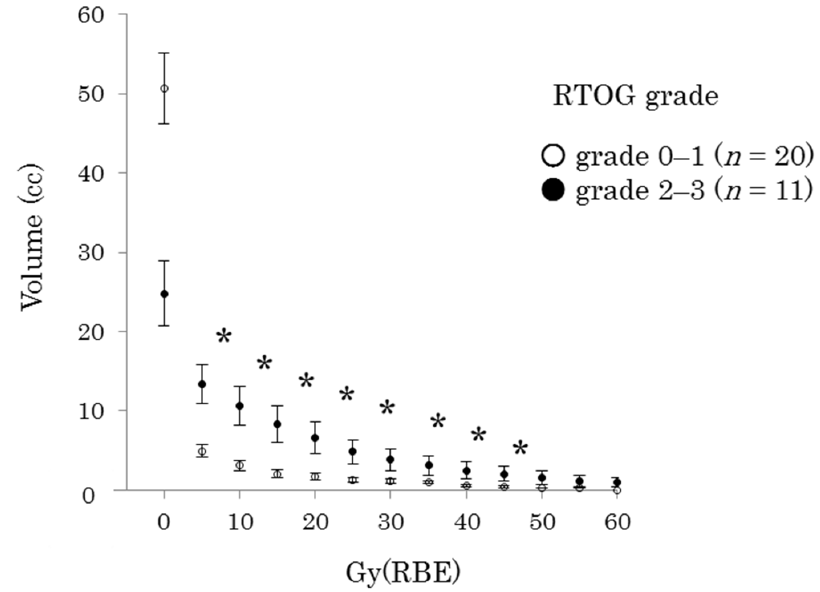
Fig 4. Comparison of a dose-volume histogram of the tongue with acute radiation mucositis (ARM) grade. ARM was graded according to the Radiation Therapy Oncology Group (RTOG) criteria. Data are presented as mean ± standard error. * p < 0.05. RBE, relative biological effectiveness.